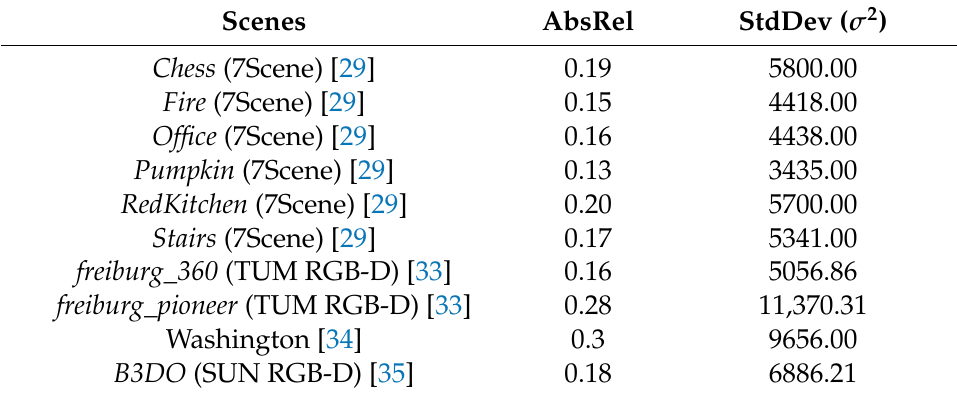
Table 3. Single-view depth estimation results on selected